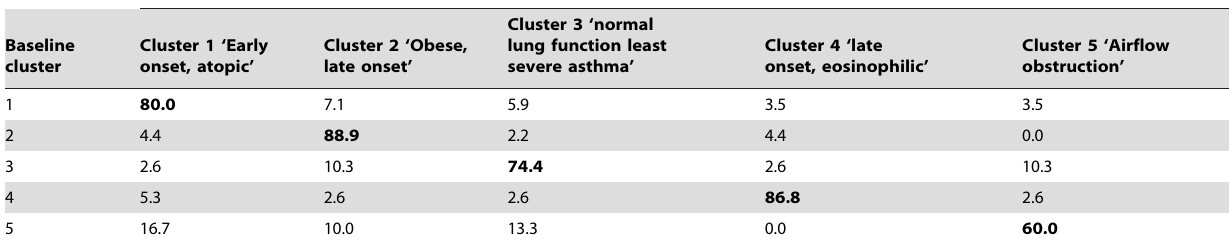
Predicted cluster classification for baseline data Baseline cluster